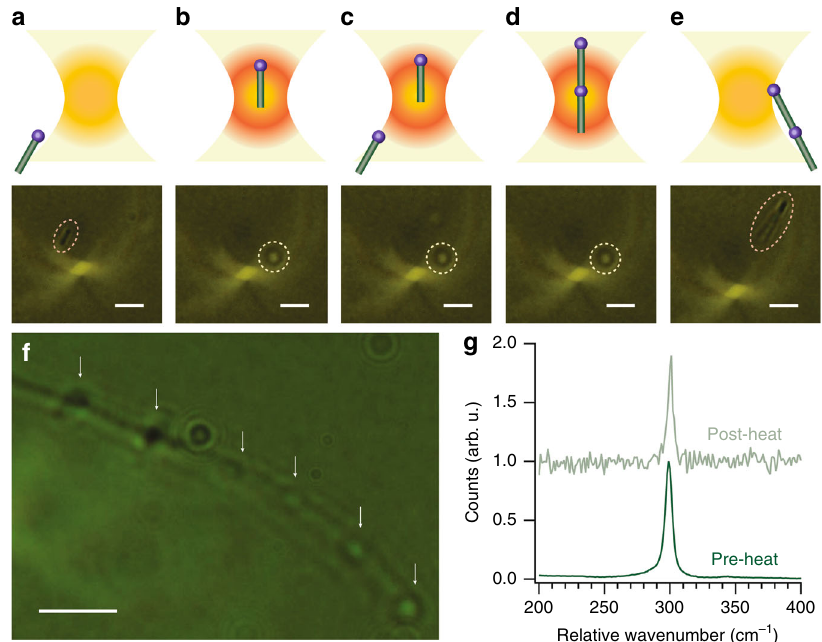
Fig. 3 Demonstration of optically oriented nanowire assembly via photonic nanosoldering. First, radiation pressure pushes ( a ) a single nanowire into the optical trap ( b ). We then bring the trapped nanowire near a second nanowire diffusing freely in Brownian motion ( c ). Forces due to asymmetric radiation pressure combined with photothermally induced laser heating result in the formation of an optically aligned coaxial heterostructure ( d ), which is subsequently released back into Brownian motion ( e ). An image showing a periodic heterostructure assembled at a trapping power of 5.5 W in an environment of squalane with DPG. The white arrows illustrate bismuth nanocrystal junctions between each of the germanium segments ( f ). Orange circles highlight freely moving, untrapped nanowires while yellow circles indicate optically trapped nanowires. Supplementary Movie 2 illustrates the assembly process. All scale bars are 2 µ m. Raman scattering ( g ) from ensembles of germanium nanowires dispersed in toluene before and after photothermal heating by both a focused (~1.5 MWcm − 2 ) and unfocused, collimated (50 kW cm − 2 ) 1070 nm laser demonstrates that